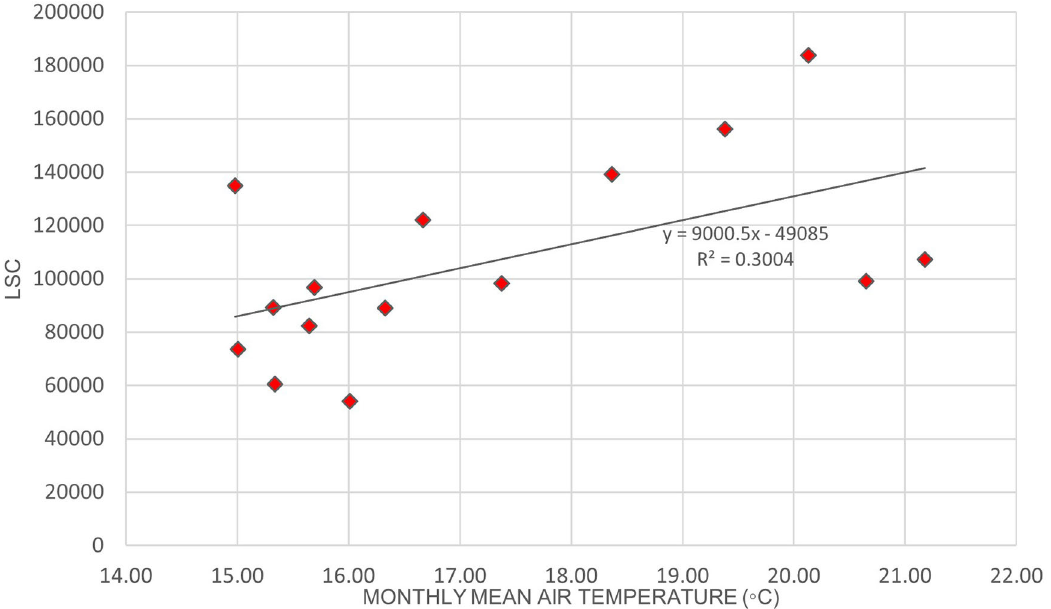
Figure 5. LSC vs air temperature over Oceania during March to July 2020.